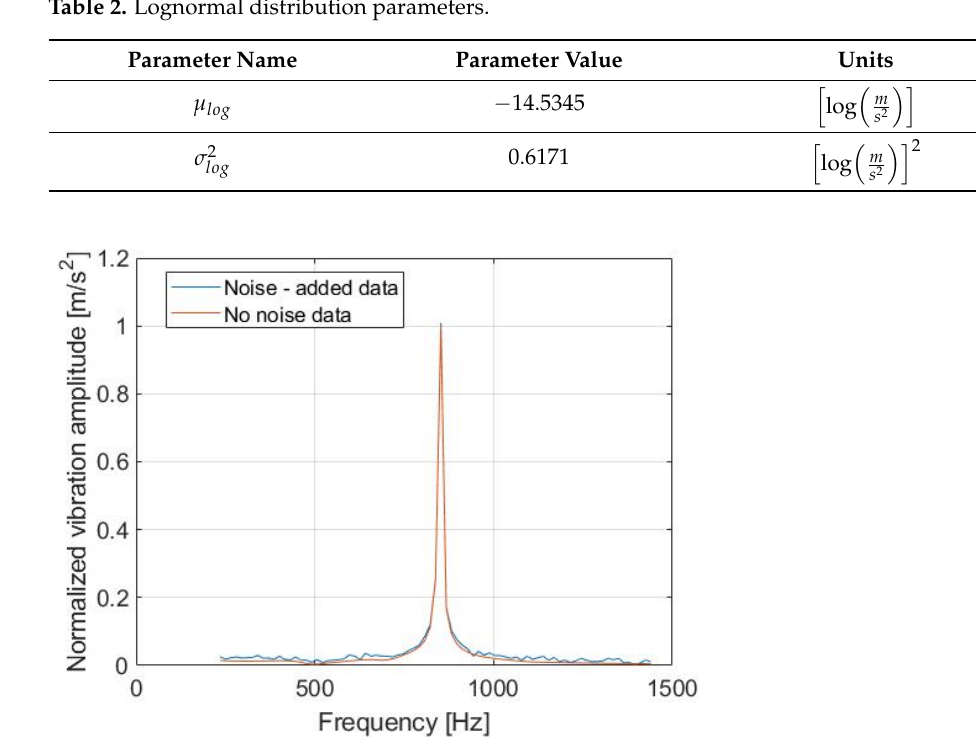
Figure 15. ( a ) FFT of vibration signal measured on the test bench and ( b ) PDF of the peaks in the range of 10–13 kHz. Table 2. Lognormal distribution parameters.